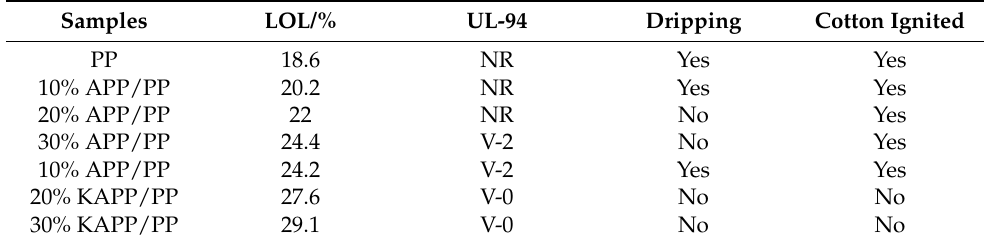
Table 9. Oxygen index and vertical combustion test results for flame retardant PP. Samples LOL/% UL-94 Dripping Cotton Ignited